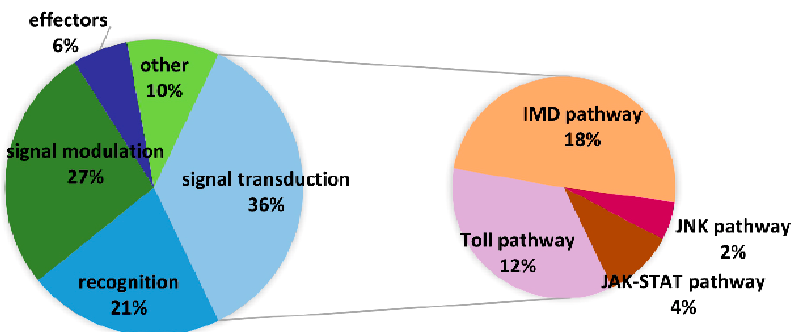
of extracellular signal modulation and intracellular signal transduction on the basis of their functions. Intracellular signal transduction genes included members of the Toll, IMD, JNK, and JAK/STAT pathways (Figure 7, Table S3). The differential expression analysis indicated that 16 genes (14 upregulated and 2 downregulated) were overexpressed in hemocytes and fat bodies (Figure 8).